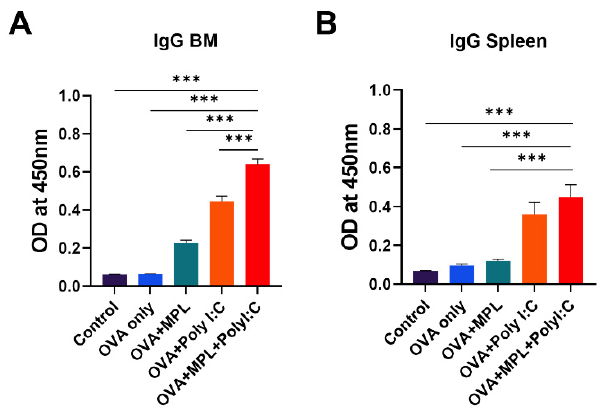
Figure 7. OVA-specific IgG production of bone-marrow cells and spleen cells from the immunized mice. BM cells ( A ) and spleen cells ( B ) were harvested from the immunized mice 2 weeks after boost immunization and cultured with OVA protein for 1 days or 7 days, respectively. Then OVA-specific IgG production was measured by ELISA. All results were shown in mean ± SEM. For statistical analysis, One-way ANOVA and Tukey’s post-multiple comparison tests were performed. *** p < 0.001 between the indicated groups.